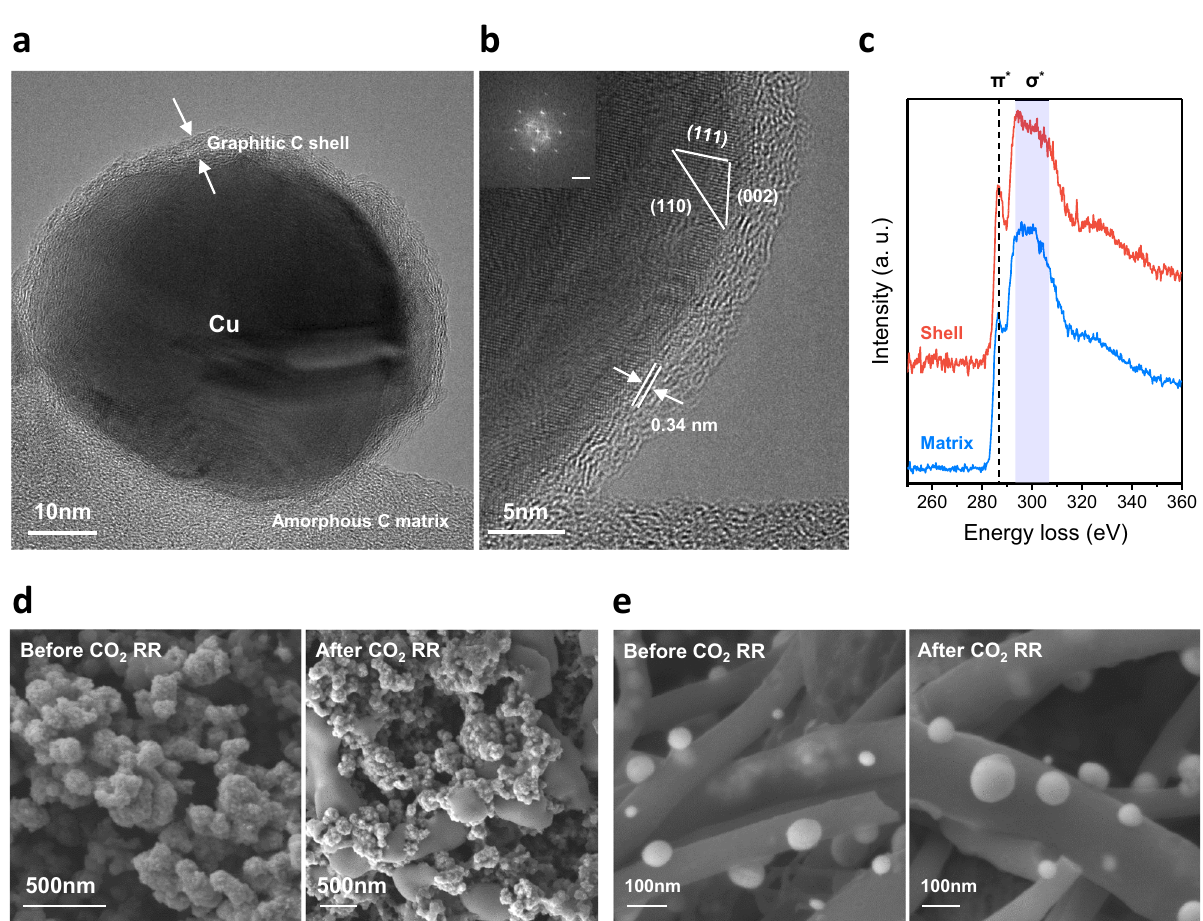
Fig. 2 Characterization of the con fi ned Cu nanoparticles and the effect on surface stabilization. a High-resolution TEM image of the con fi ned Cu nanoparticles and quasi-graphitic C shell. b Atomic lattice of the Cu nanoparticle and C shell. c EELS spectra of the amorphous carbon matrix and quasi- graphitic C shell. The peaks under the dotted line and blue area represent π * and σ * bonding, respectively. Surface structure of the ( d ) uncon fi ned and ( e ) con fi ned Cu nanoparticles before and after the CO 2 RR,